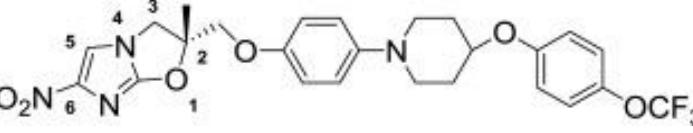
Figure 5. Structure of delamanid [ 69 ].